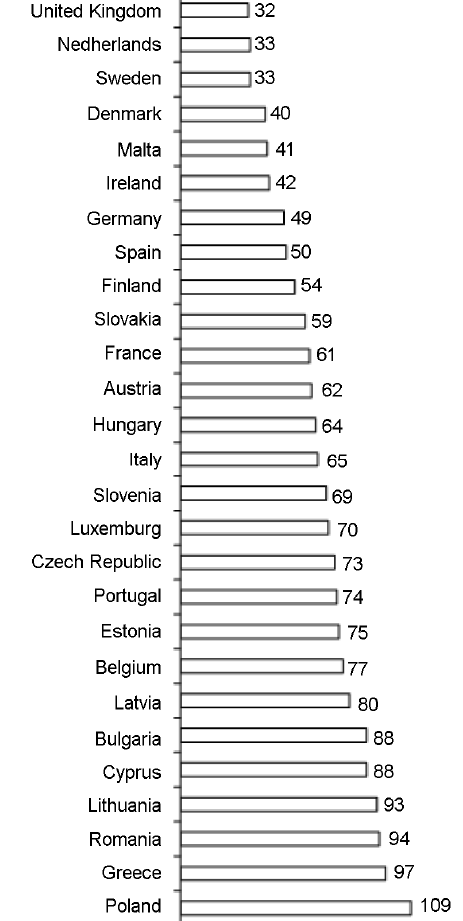
Fig. 1. The distribution of the number of people killed (per million population) in road accidents in the EU Member-States in 2011